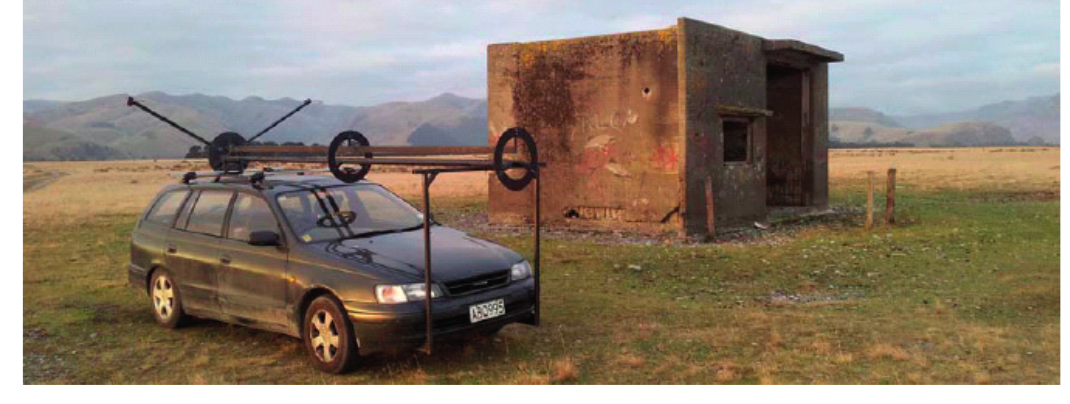
Figure 18. World War II storage bunker on Kaitorete